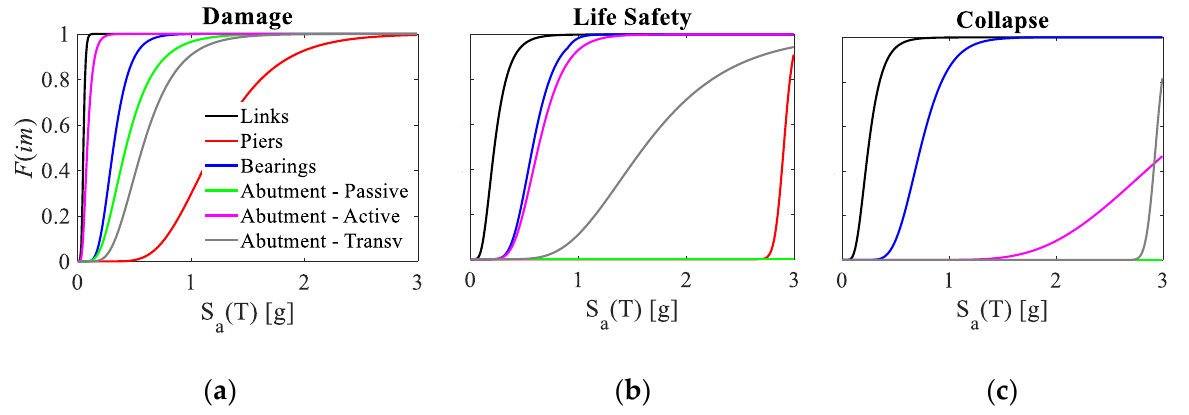
Figure 11. Failure mode fragility curves compared at specific performance levels: ( a ) damage; ( b ) life safety; and ( c ) collapse.